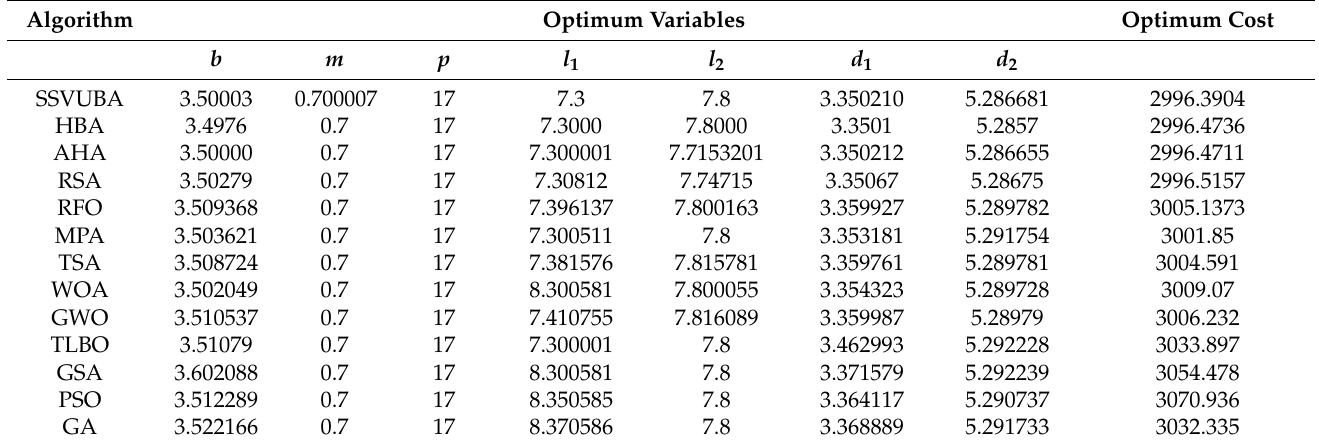
Table 12. Performance of optimization algorithms in the speed reducer design problem.